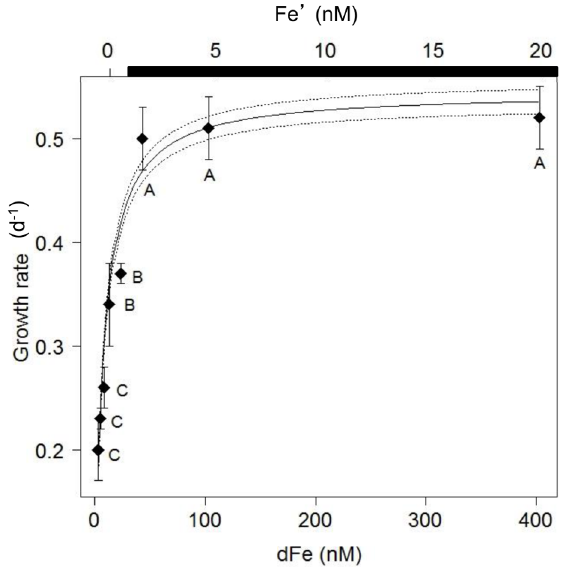
Figure 1. Growth rate of C. watsonii related to dFe and Fe 9 concentrations. Error bars represent standard deviation; different letters correspond to statistically different means ( p , 0.05) and the black bar indicates the region of expected Fe hydroxide precipitation. The Monod regression, performed with dFe concentrations, is represented by the black line and standard deviation of regression by dotted lines.